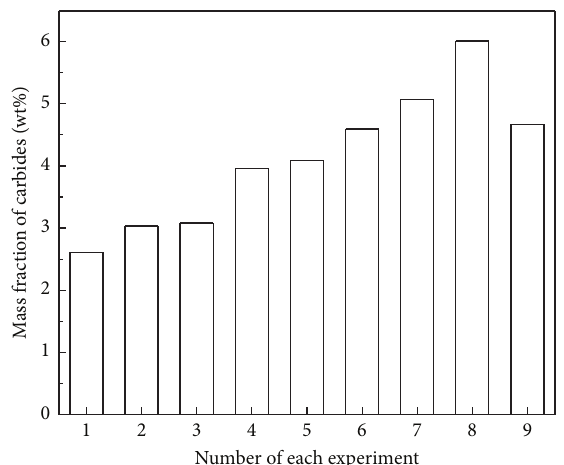
Figure 2: Mass fraction of carbides.